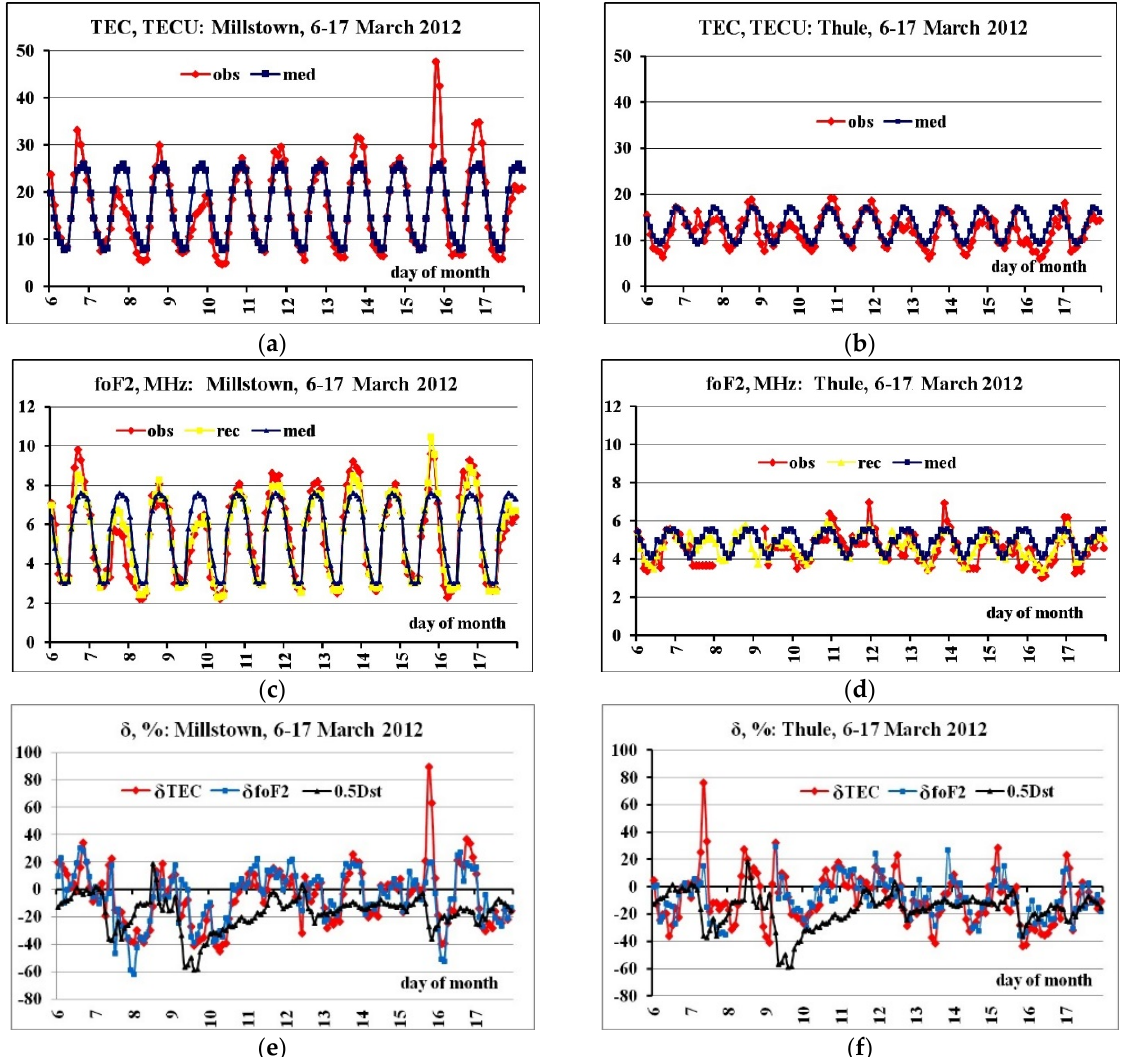
Figure 7. Parameter variations during 6–17 March 2012 at Millstone Hill station (left panels) and Thule station (right panels): ( a , b ) observed and median TEC values; ( c , d ) observed, median and reconstructed foF2 values; and ( e , f ) δ TEC, δ foF2 and 0.5Dst variations